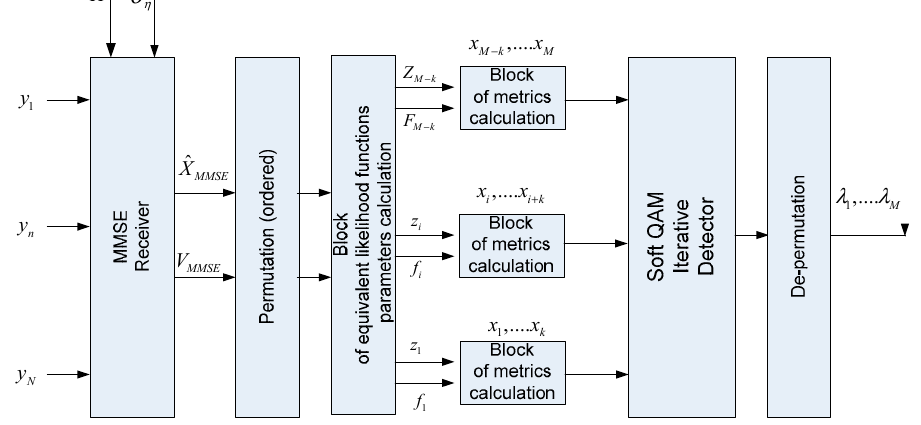
Figure 2. Generalized block diagram of a MIMO demodulation algorithm using an MMSE detector for factorization or MIMO channel matrix